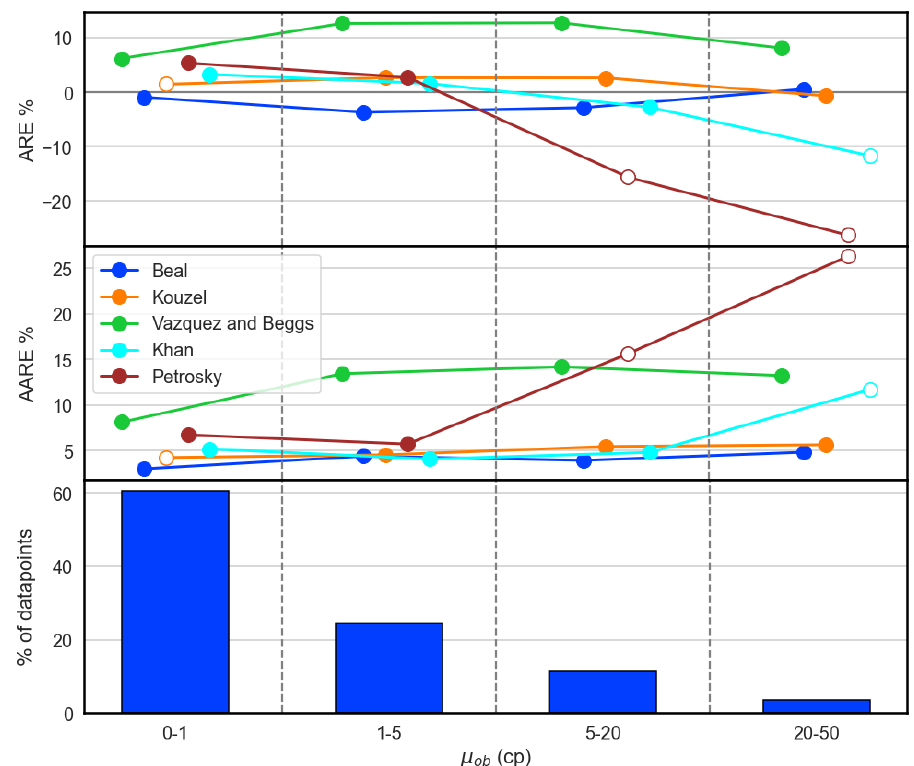
Figure 4. Evaluation of correlations in cluster A 1 (hollow points correspond to results obtained outside the development range of the correlation).